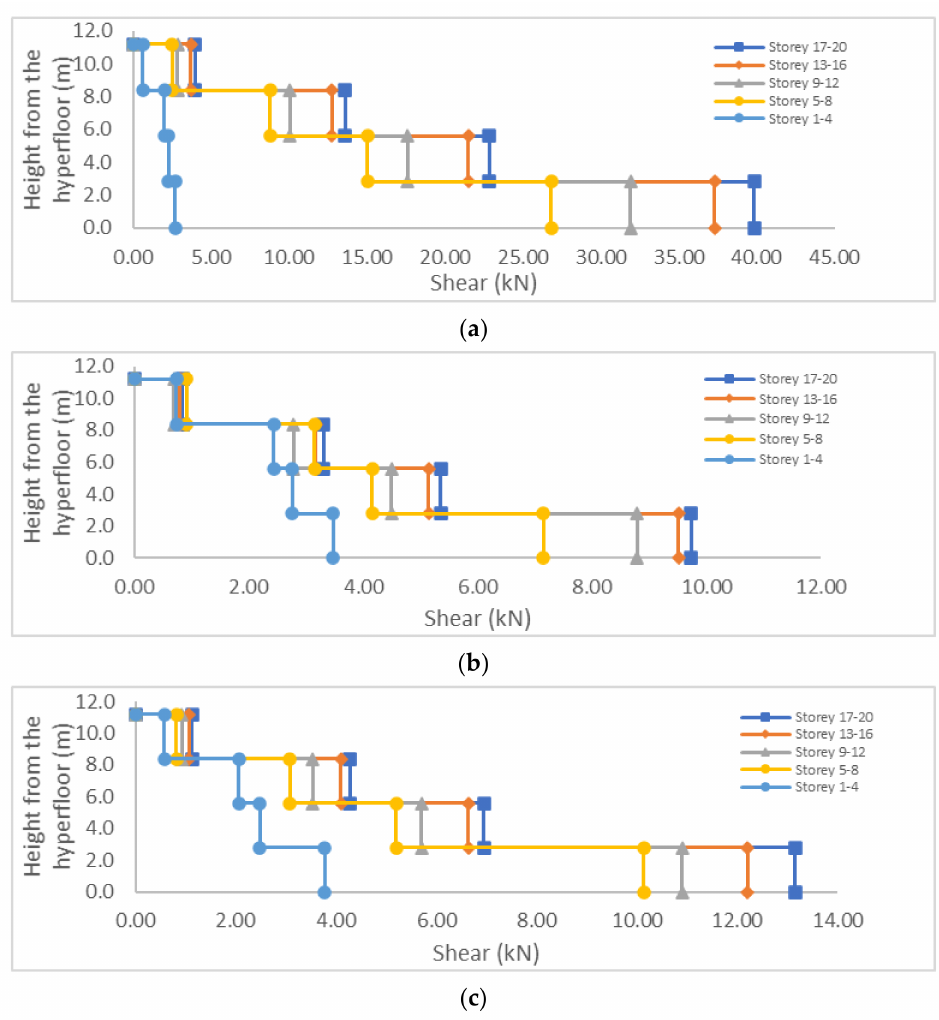
Figure 18. Shear experienced by the shearwall segments of the long modules under factored seismic- load combination 1.0 E + 1.0 D + 0.5 L + 0.25 S. The end shearwall segments of 3.475 m length are shown in ( a ), the segment of 3.0 m length are shown in ( b ) and the segment of 3.5 m length are shown in ( c